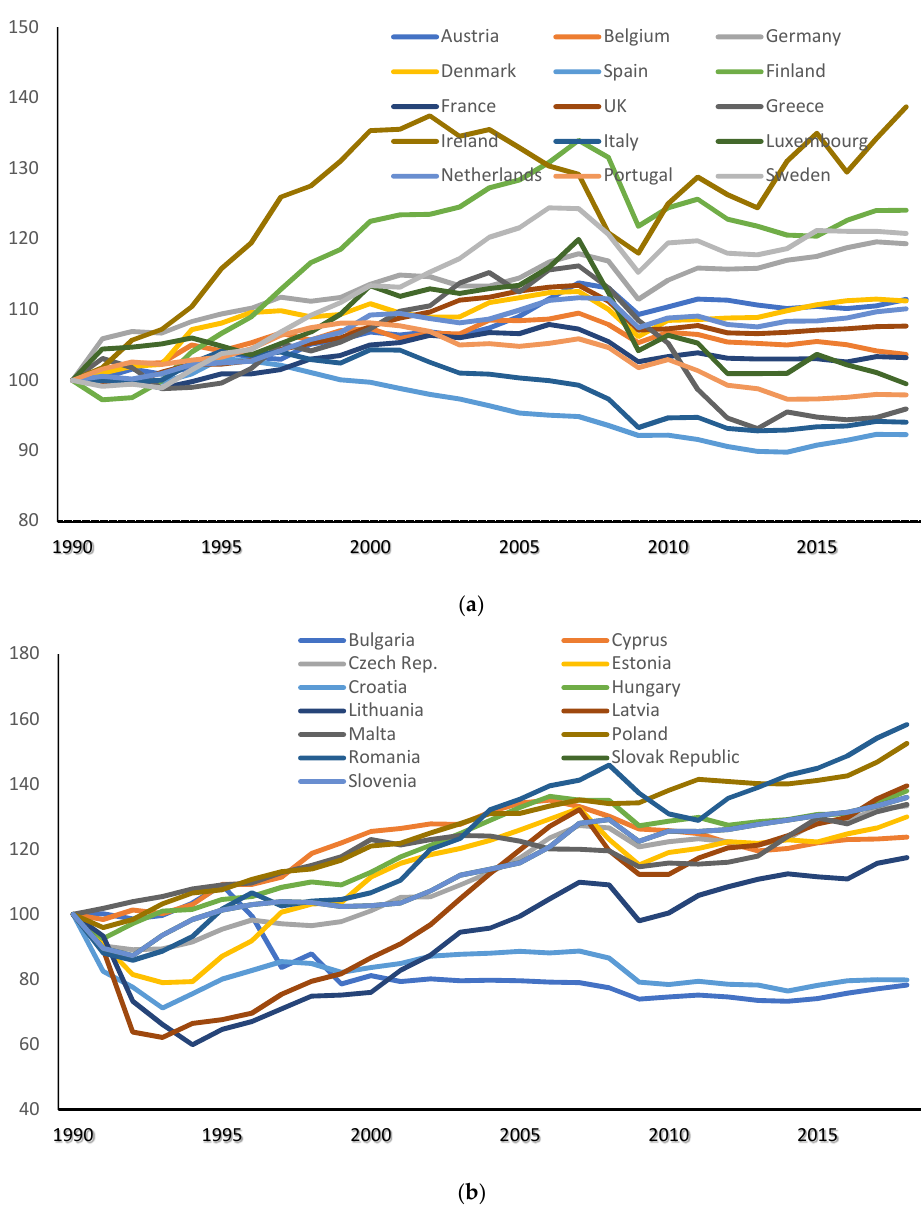
Figure 1. ( a ) TFP dynamics by country, EU15 countries, 1990–2018. ( b ) TFP dynamics by country, EU13 countries, 1990–2018.